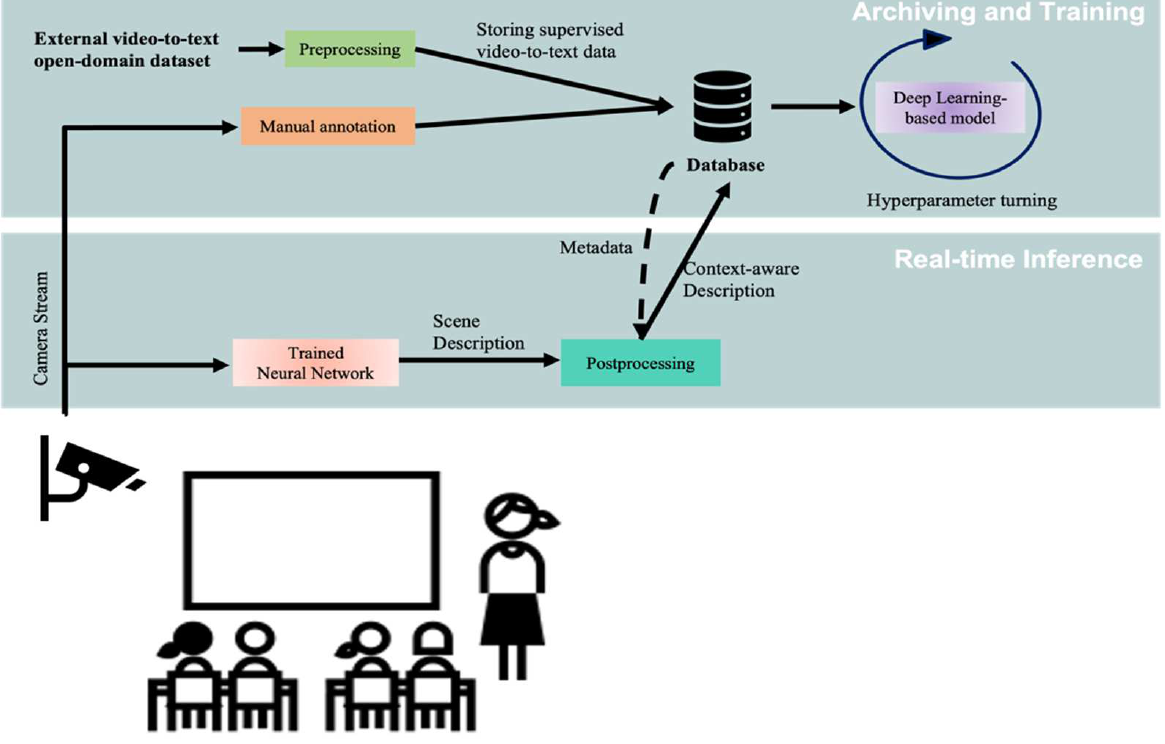
Figure 1. Overview of the proposed framework applied in a classroom monitoring application.